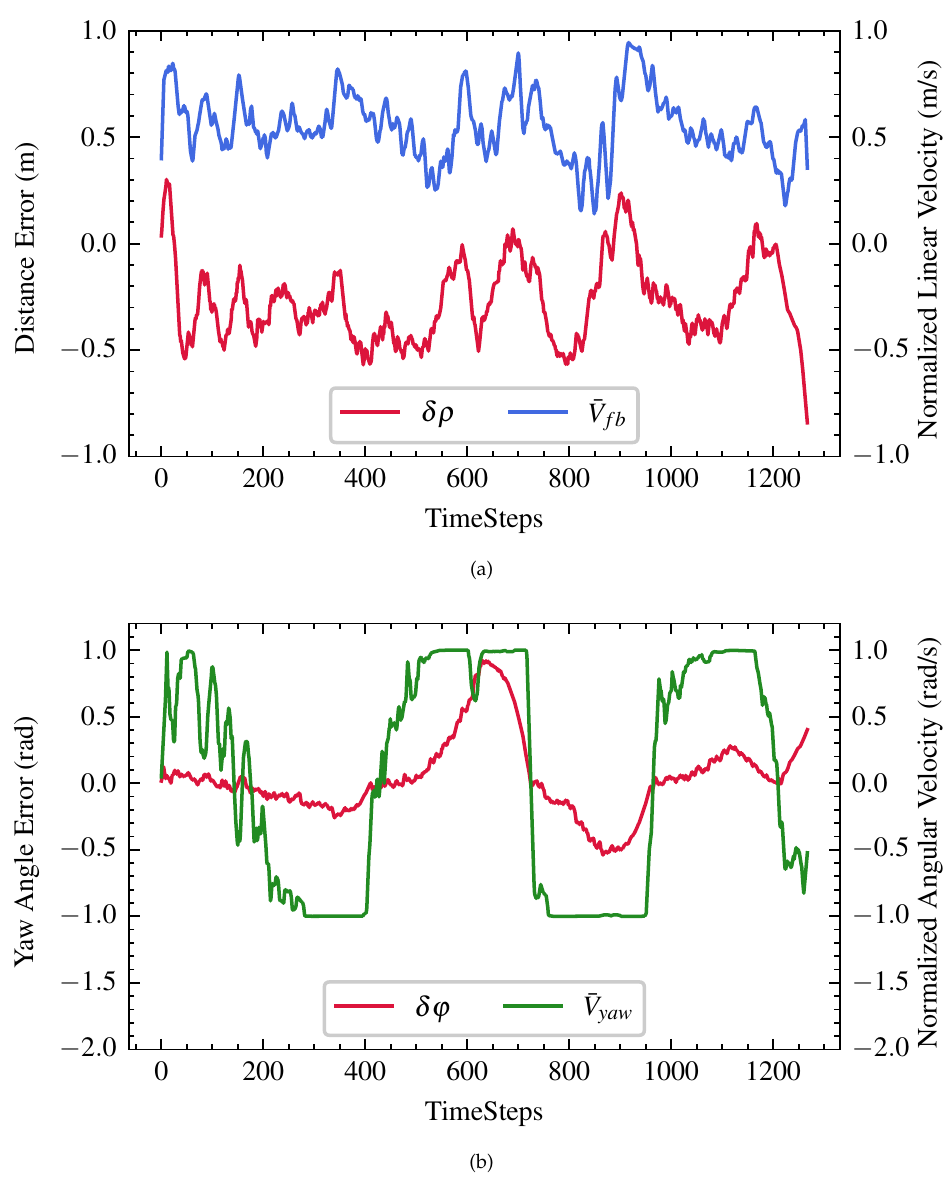
Figure 10. Visualization of the sequences of the state errors and the corresponding actions. ( a ) Com- parison of sequences for the ground truth distance error and the output normalized linear velocity. ( b ) Comparison of sequences for the ground truth yaw angle error and the output normalized angular velocity.